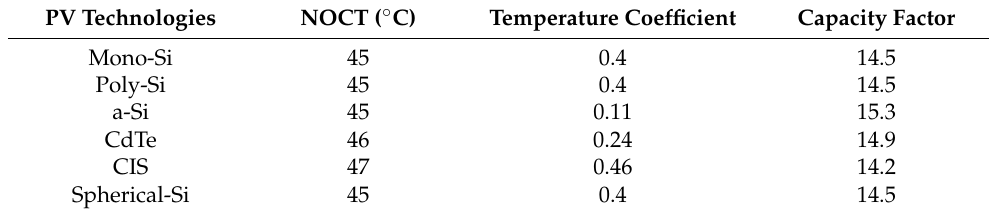
Table 5. Investigating PV technologies in